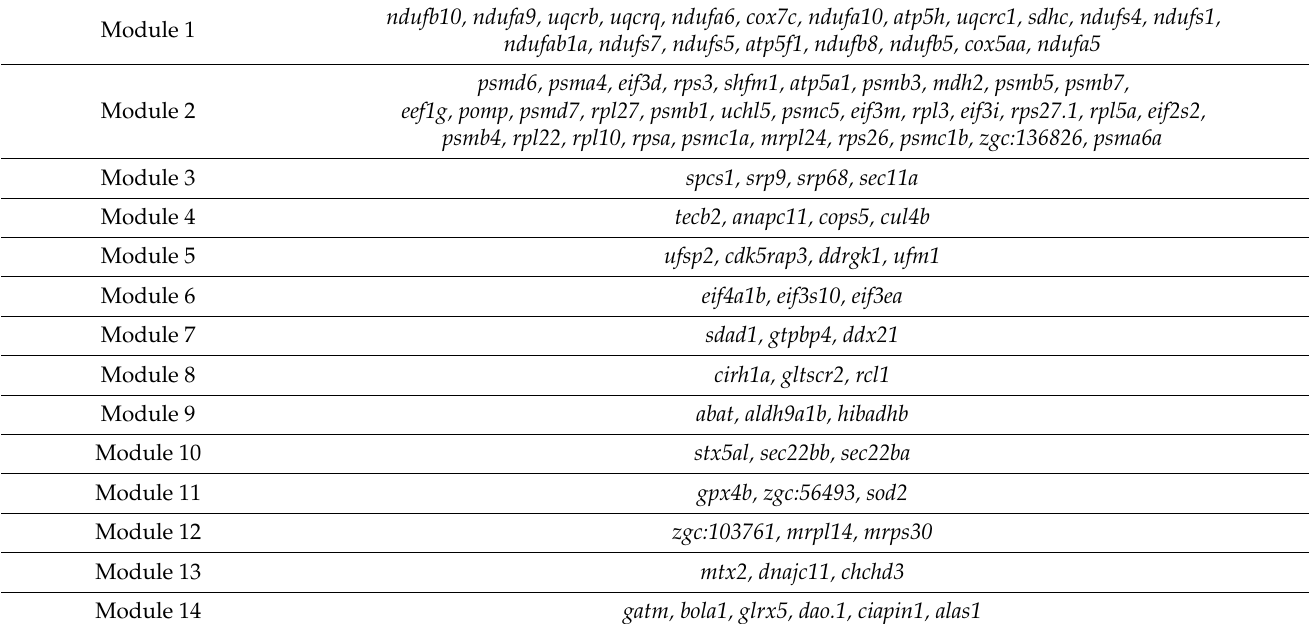
Table 3. List of genes in identified PPI modules affected by starvation in